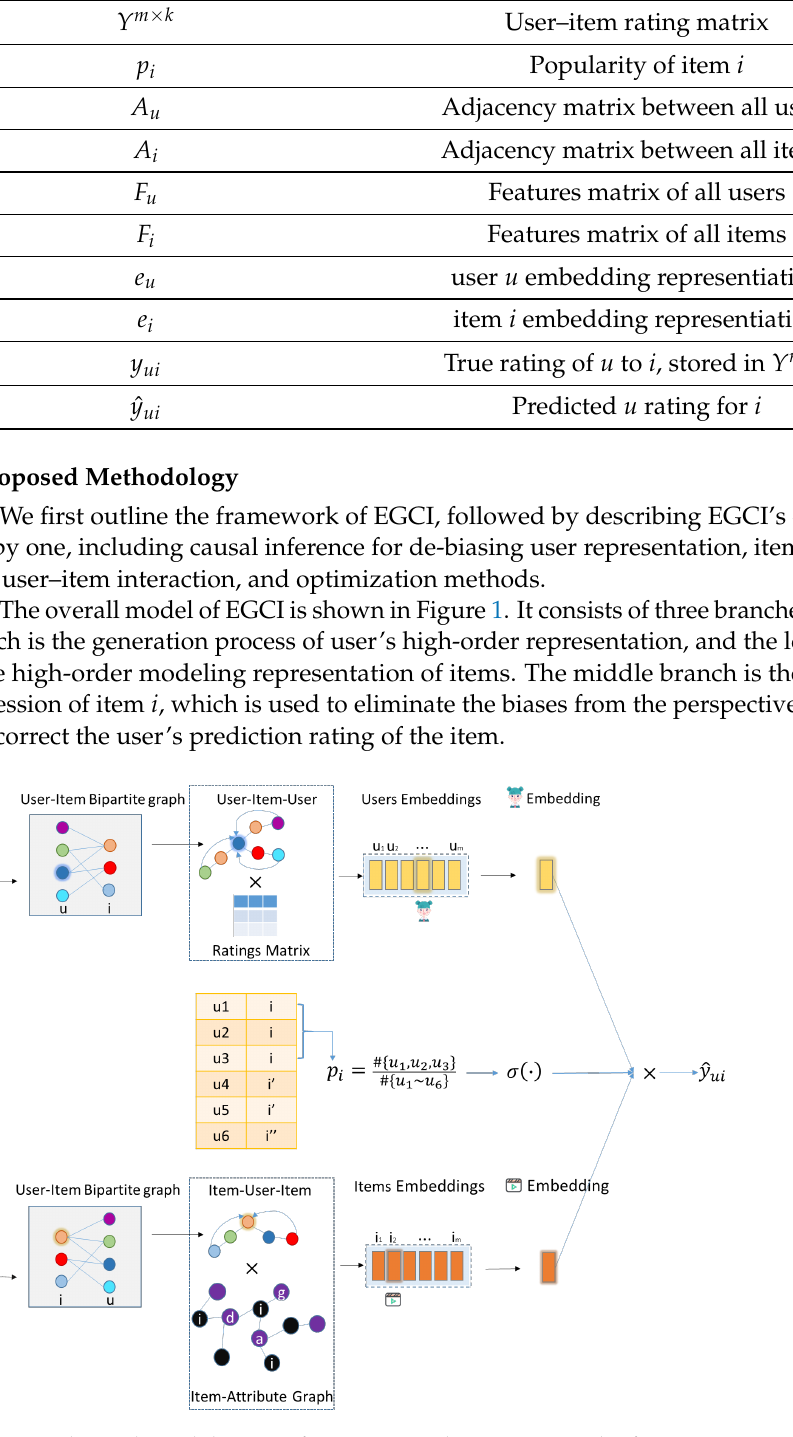
Figure 1. Enhanced graph learning for recommendation via causal